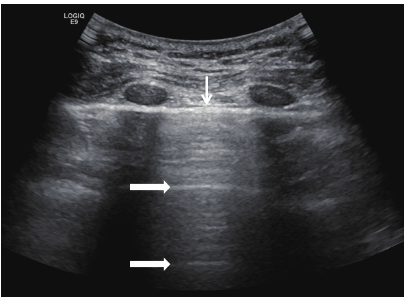
Figure 2 A-line. The two-dimensional ultrasound image parallel to the pleural line are the A-line (2 thick arrows) and pleural line (thin